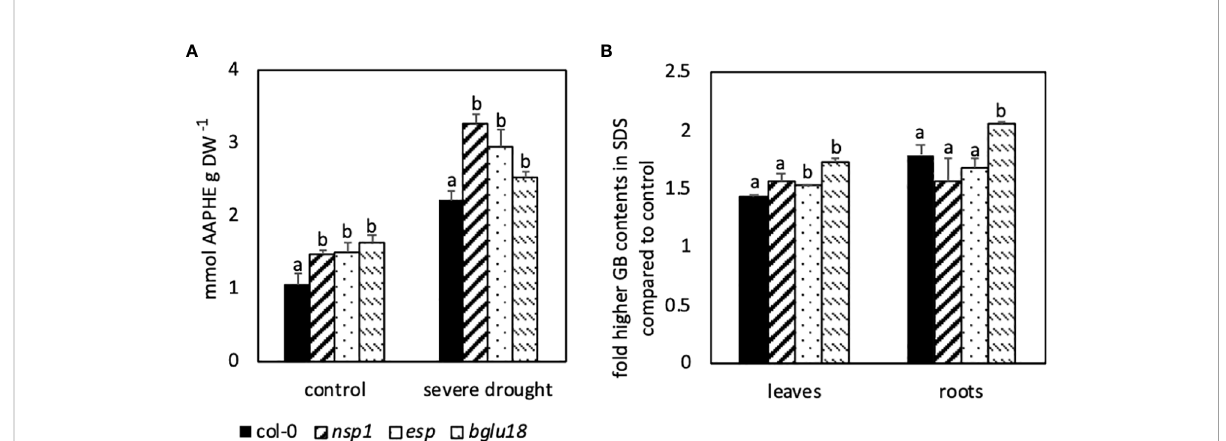
FIGURE 6 Differences in contents of reactive oxygen species (ROS) analyzed as 2,2 ′ -azobis(2-amidino-propane) equivalents (AAPHE; A ) and in fold higher contents of glucobrassicin (GB, B ) in different mutants. Five-week-old Arabidopsis thaliana plants were subjected to severe drought stress (40% PEG 20,000) for 7 days. Bars represent means of two independent experiments consisting of three biological replicates consisting of four pooled plants each. Different letters indicate signi fi cant differences (p<0.05) between mutants and the wild-type Col-0.